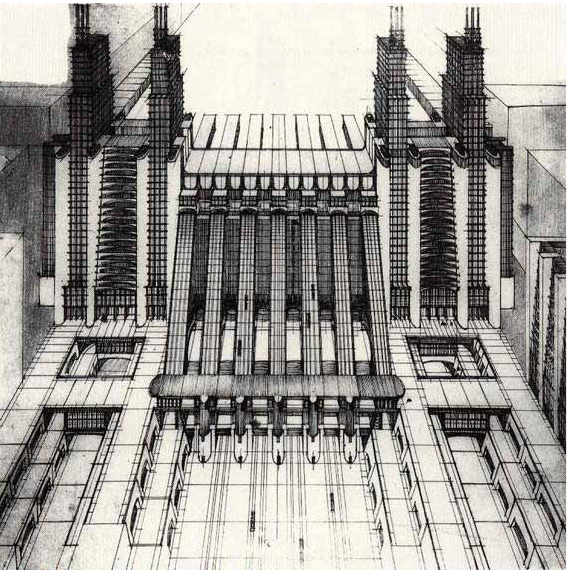
fig. 10. antonio Sant’Elia: multi-level railway station (1914)